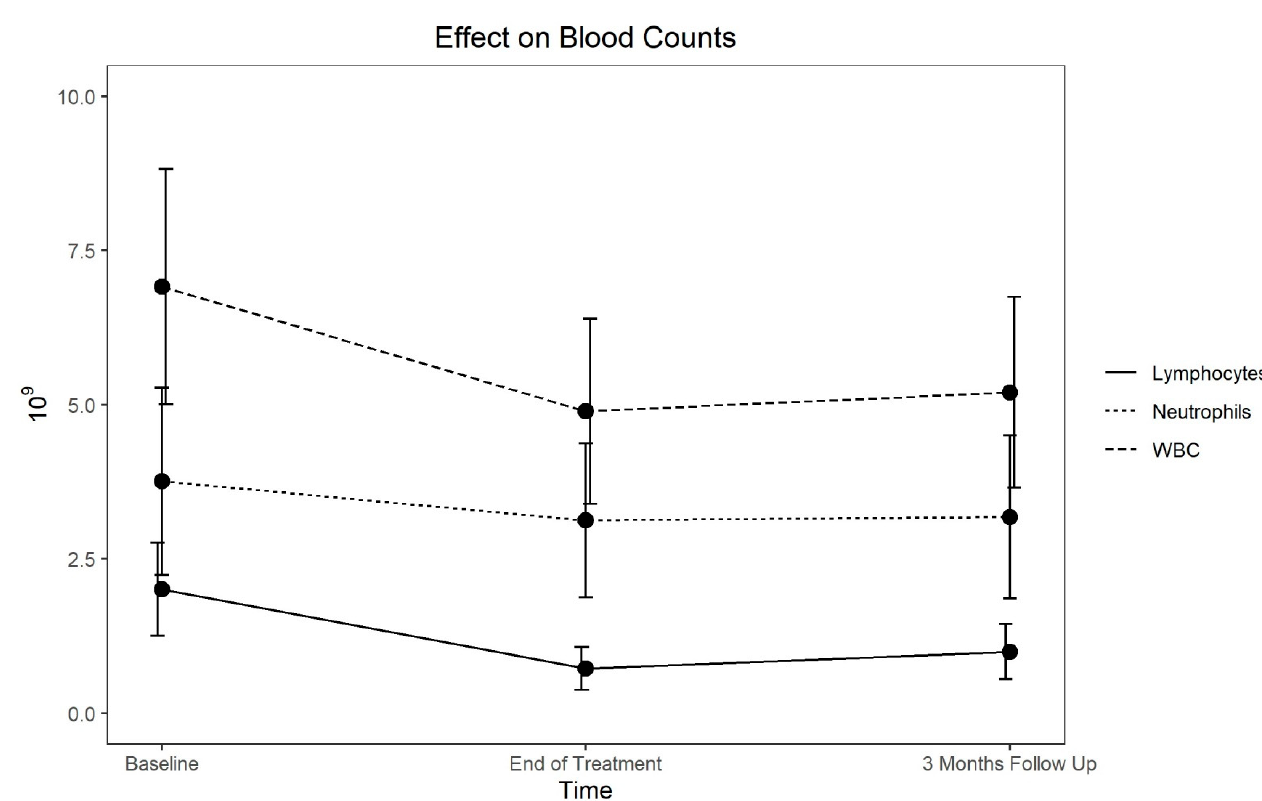
With the longer follow-up, the field-size effect differences resolved for all the counts, except for the lymphocyte.